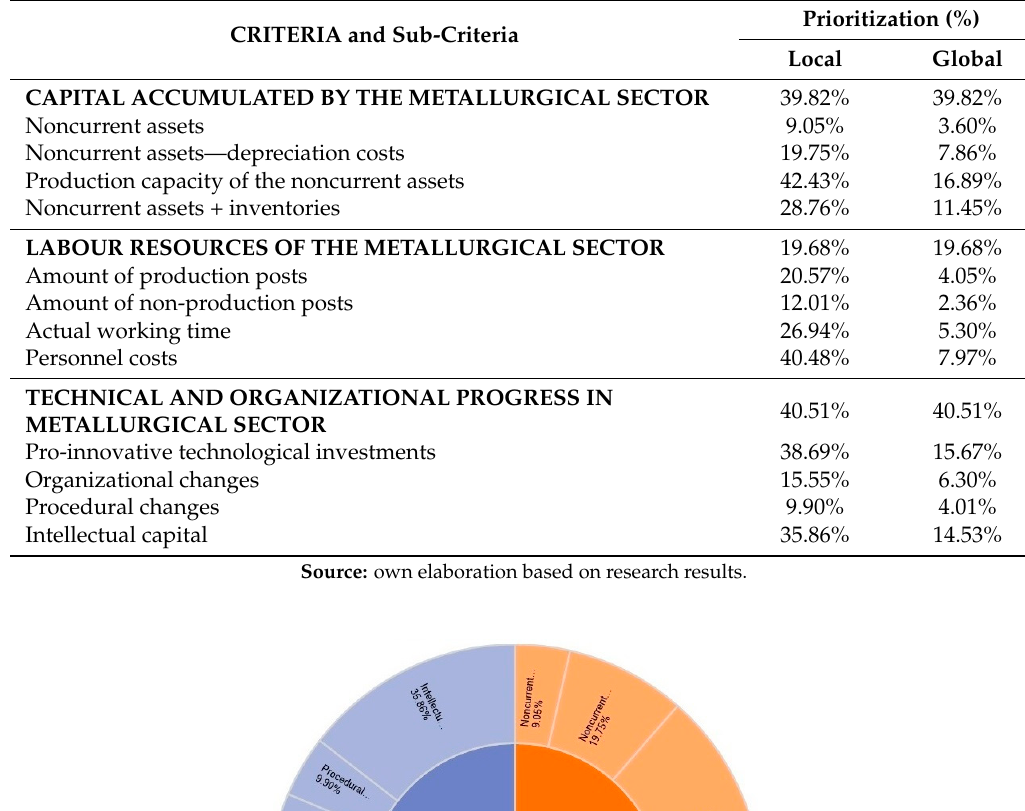
Table 2. Local and global prioritization of decision criteria and sub-criteria (%).